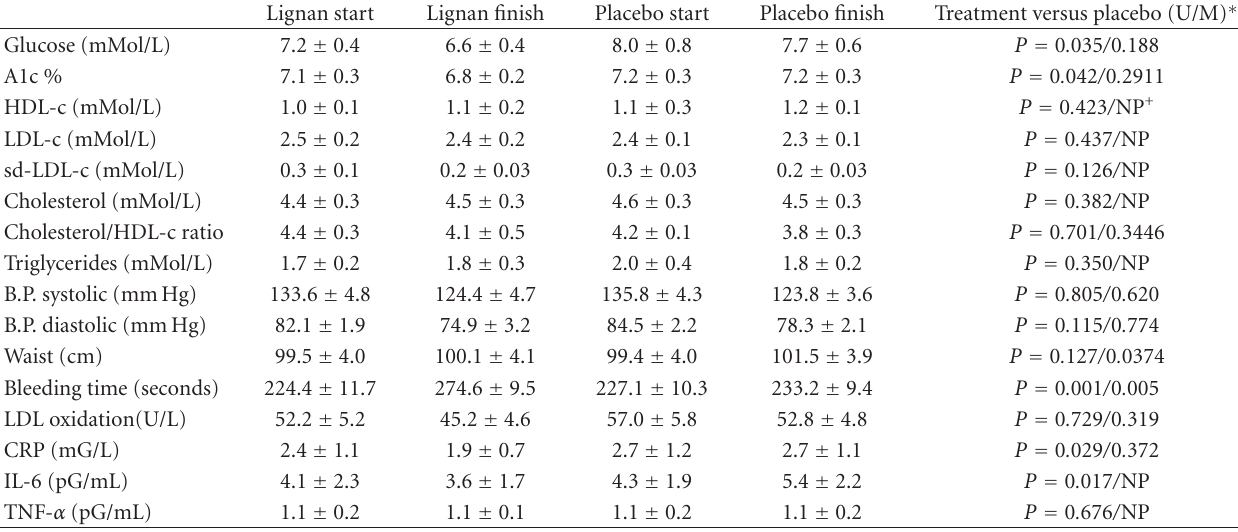
Table 2: Impact of flaxseed lignan complex on hyperglycaemia, dyslipidaemia, blood pressure, waist circumference, bleeding time, LDL oxidation, and inflammation. Lignan start Lignan finish Placebo start Placebo finish Treatment versus placebo (U/M) ∗